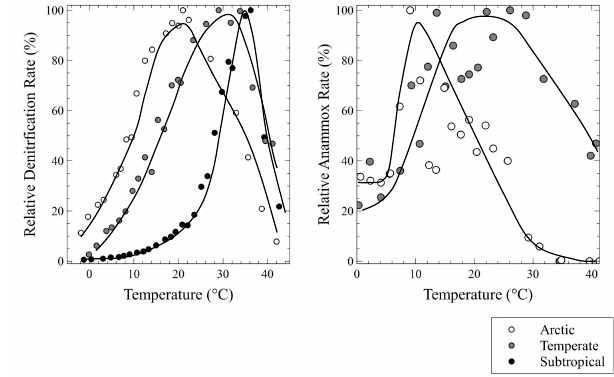
Fig. 5. Left: normalized temperature response of denitrification for subtropical, temperate, and Arctic sites. Right: normalized temper- ature response of anammox for temperate and Arctic sites. Curves were visually fit and error bars are omitted for